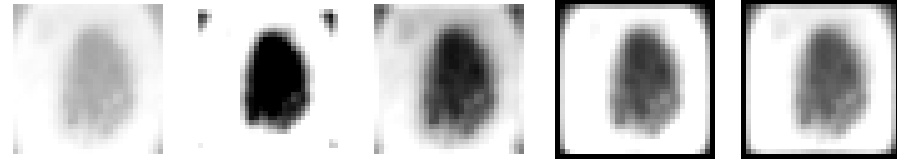
Figure 7. Some instances of the dermoscopic image features generated by a previous block.